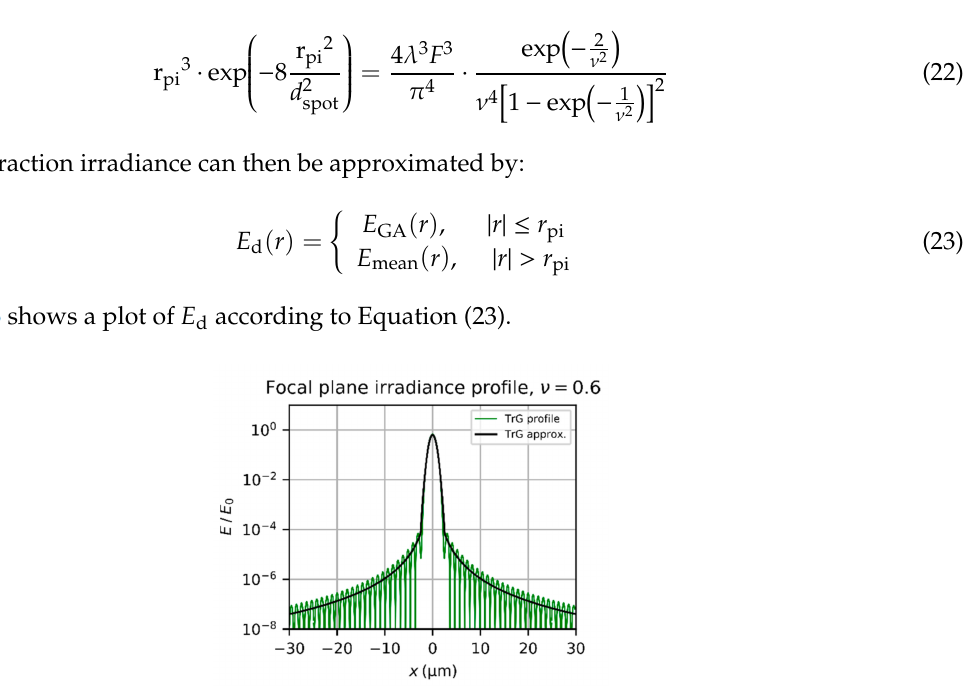
Figure 6. Irradiance profile of the di ff raction pattern of a truncated Gaussian beam (TrG) and its approximation according to Equation (14) and Equation (23), respectively. Calculation parameters: λ = 532 nm, f = 50 mm, F = 2.0, ν = 0.6. The curves are normalized using the peak irradiance E 0 of an Airy di ff raction pattern for same incident power P in